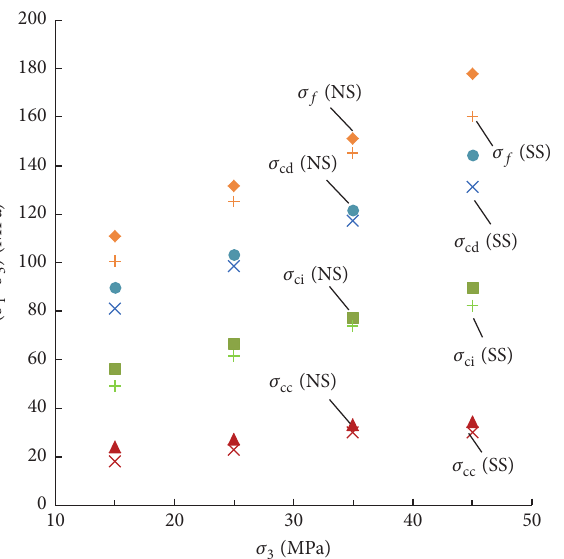
Figure 8: The feature point stress versus the confining pressure.